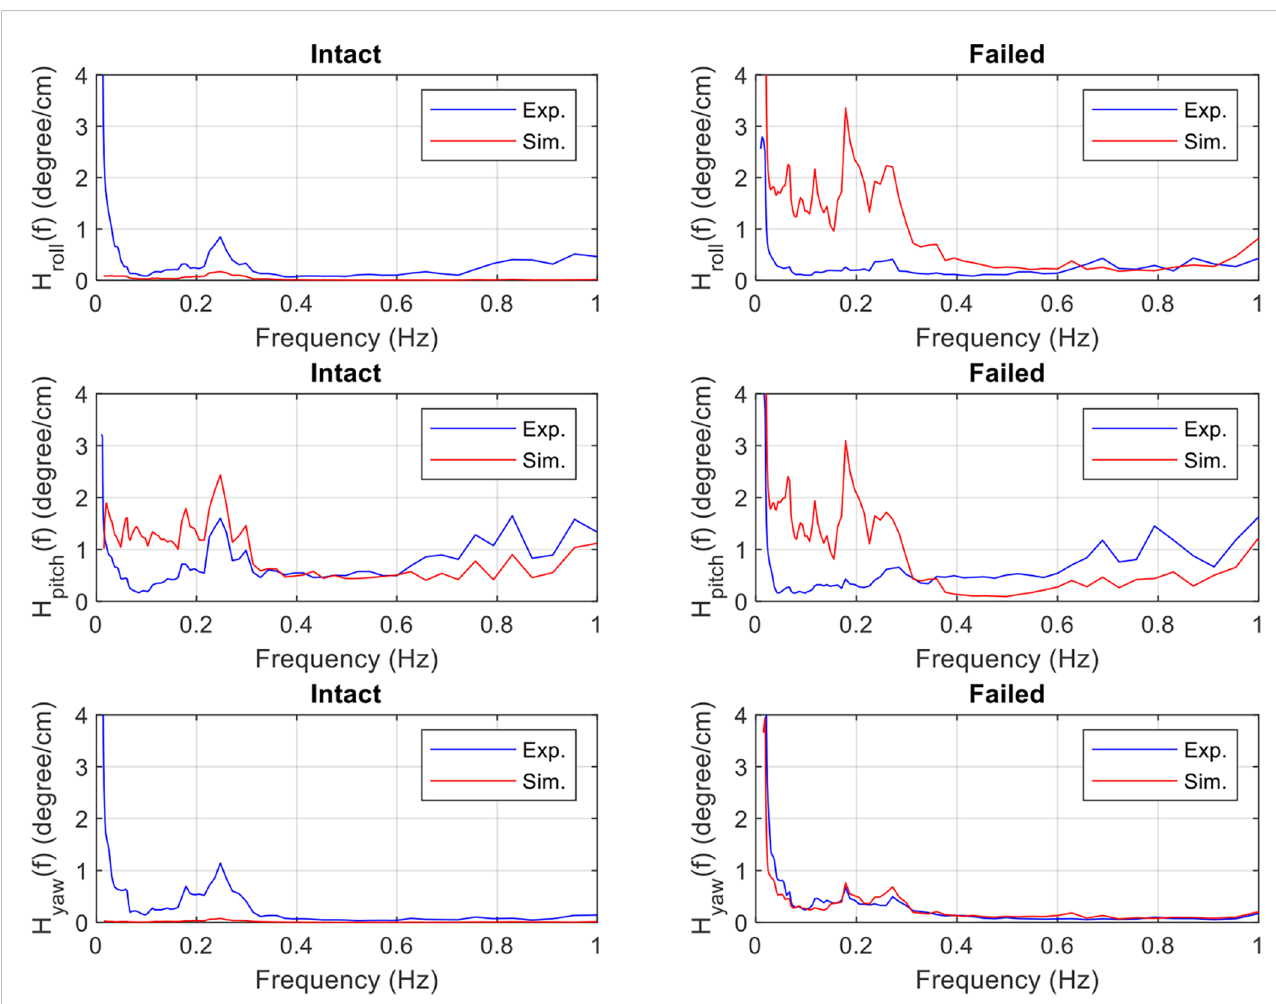
FIGURE 9 Transfer functions of the roll, pitch, and yaw motions of the fl oating collar in the experiment and simulation under the intact and failed